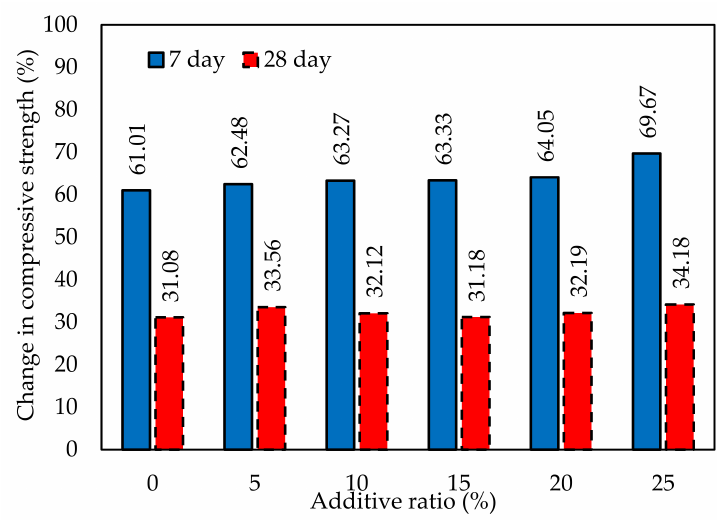
Figure 12. Change in compressive strength of FBP-based cementitious